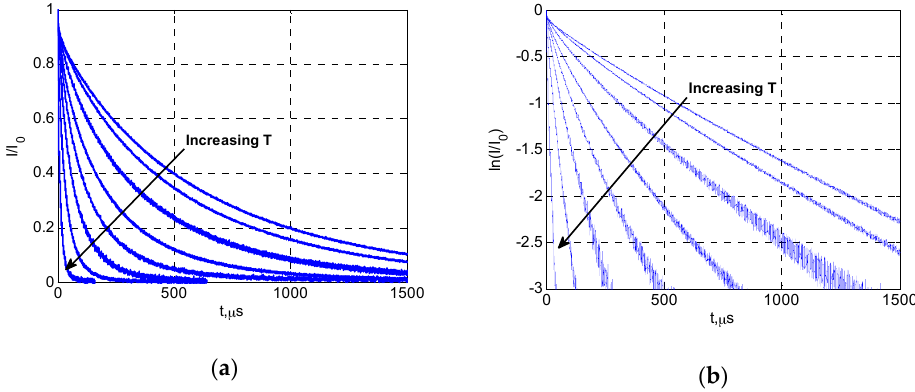
Figure 5. Decay curves of YSZ:Dy at different temperatures: ( a ) normalized intensity; ( b ) logarithm of normalized intensity.